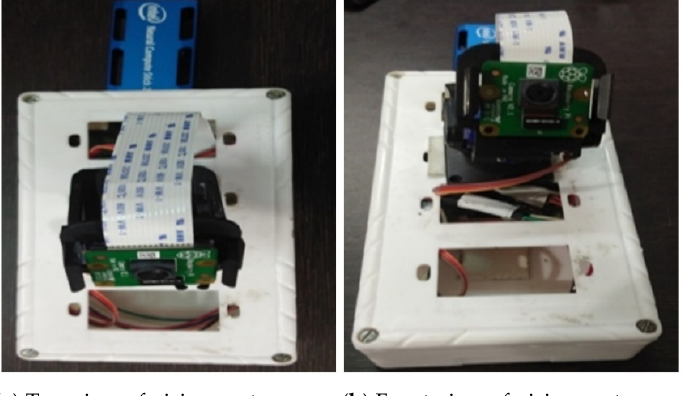
Figure 4. Customized vision mote.